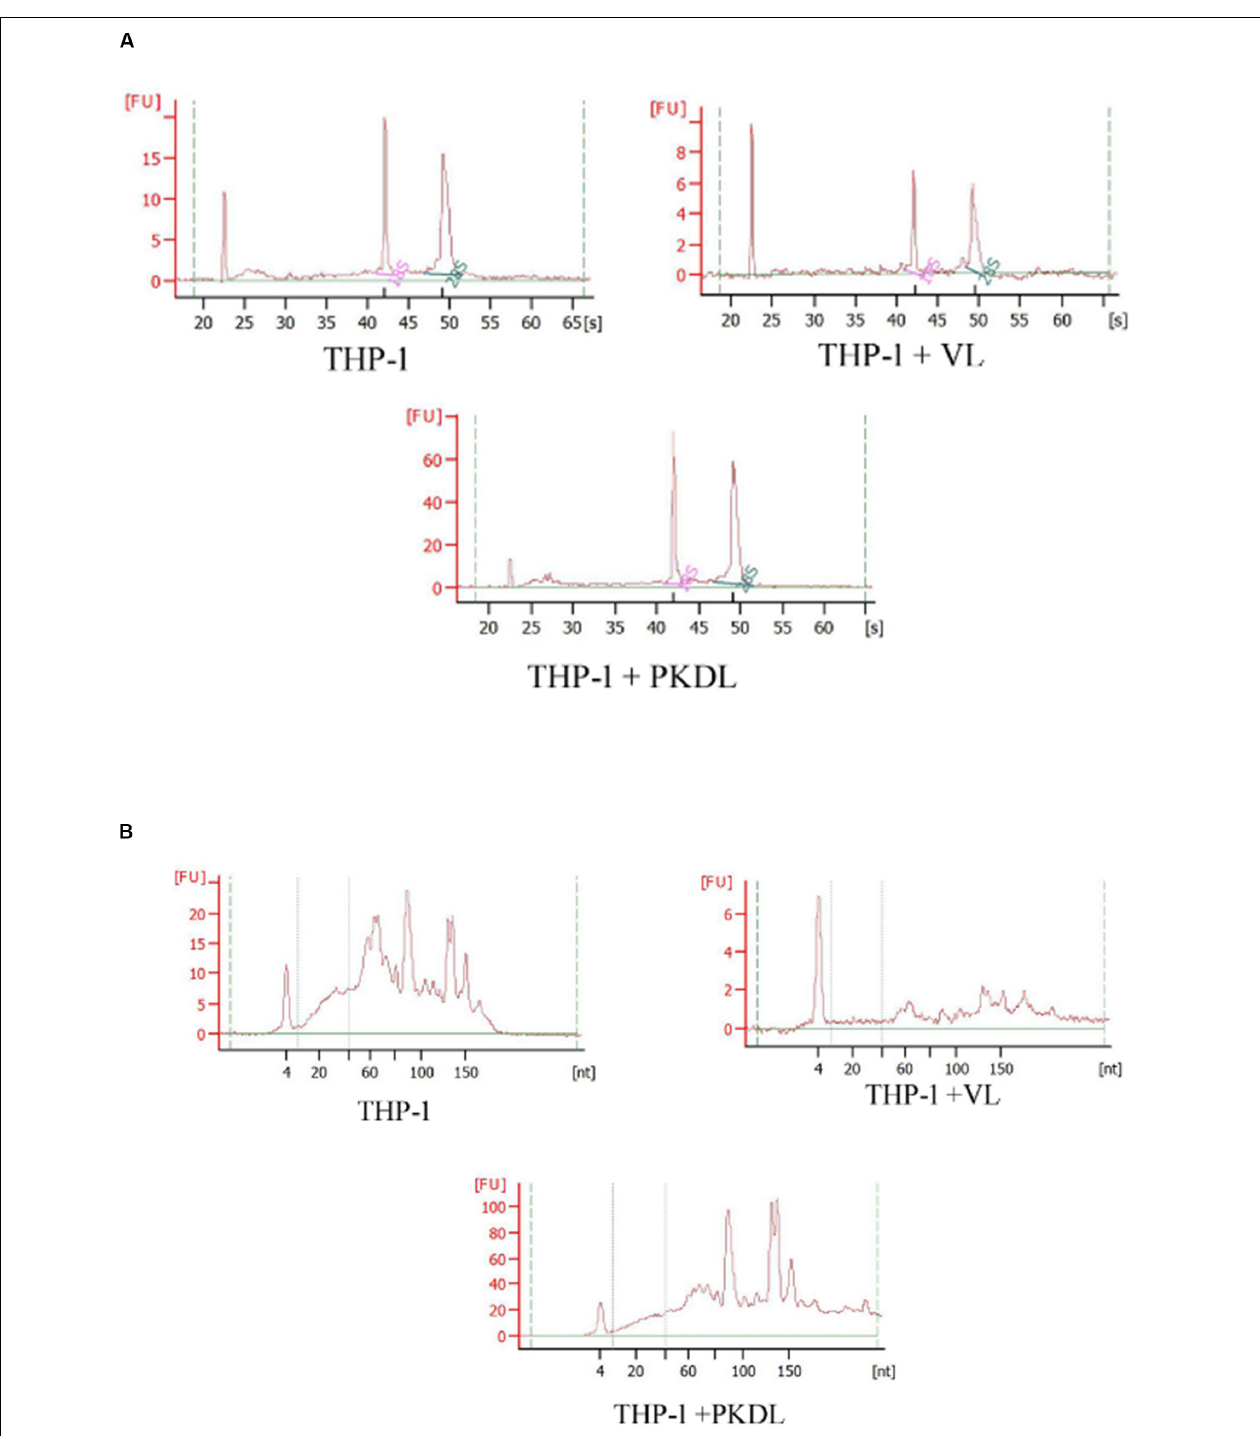
FIGURE 2 | RNA integrity assessment based on the ratio of 28S:18S rRNA, estimated from the (A) band integrity or (B) densitometry plot.